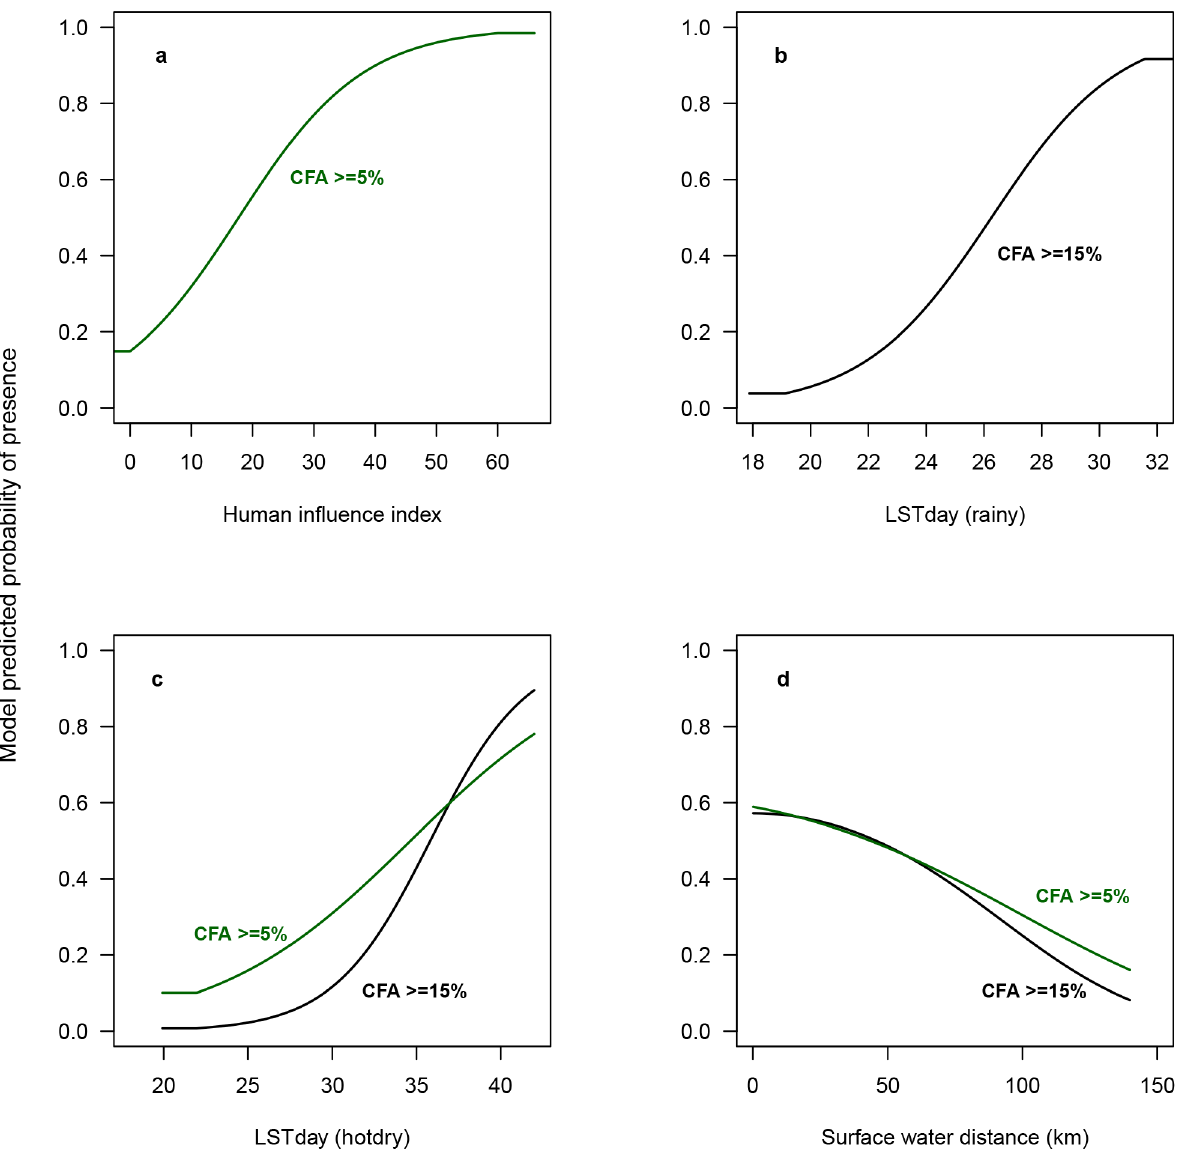
Figure 2. Response curves illustrating the relationship of MaxEnt predicted probability of occurrence to environmental variables. The values shown on the y-axis is the predicted probability of suitable conditions, as given by the logistic output format, with only the particular predictor variable used to develop the MaxEnt model. (a) The figure shows the relationship between the Human Influence Index and the predicted probability of occurrence of CFA $ 5% (model 1), (b) depicts the relationship between day-time land surface temperature in the rainy season (LSTday (rainy)) and the probability of LF as modeled by model 2 (CFA $ 15%), (c) shows the relationships between day-time land surface temperature in the hot-dry season (LSTnight (hot-dry) and the probability of LF occurrence as modeled by model 1 and 2, respectively, and (d) shows the relationship between the distance to nearest surface water bodies and the probability of occurrence of LF as modeled by model 1 and model 2, respectively.